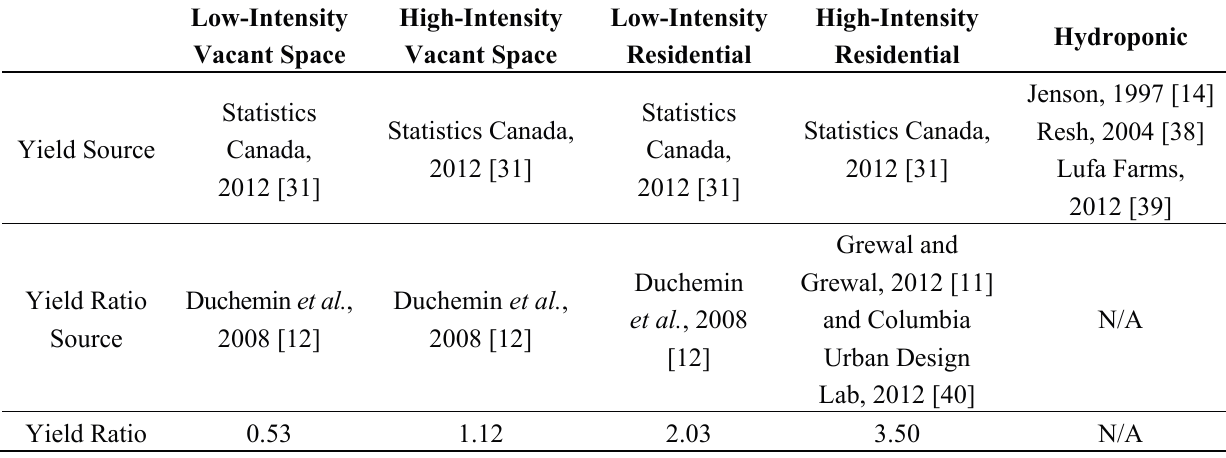
Table 1. Sources of yield and yield ratio data for various farm management